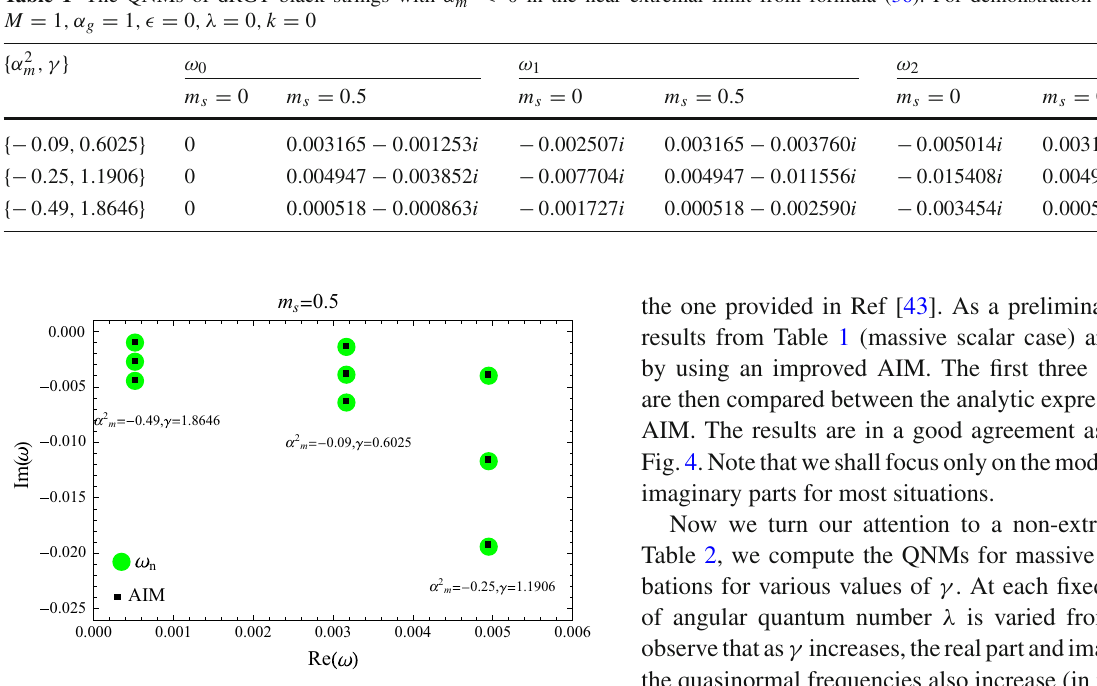
Fig. 4 The comparison between the QNMs in the near extremal limit obtained via formula (36) and numerical method of AIM The final equation